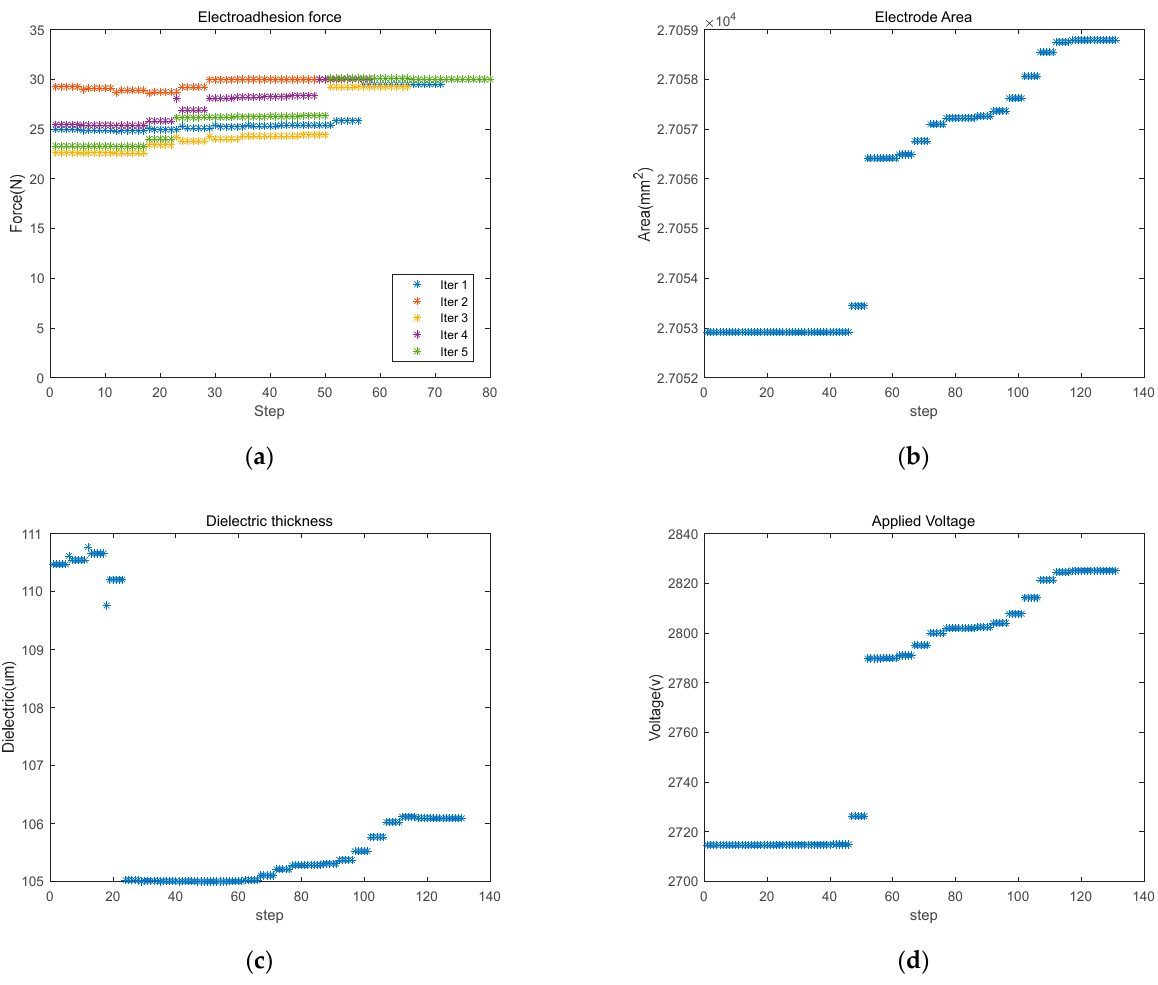
Figure 11. Modeling and analysis data comparison verification: ( a ) applied voltage; ( b ) electrode area; ( c ) dielectric thickness; ( d ) dielectric permittivity. Table 6. Optimal dimension and specification for the FEM design